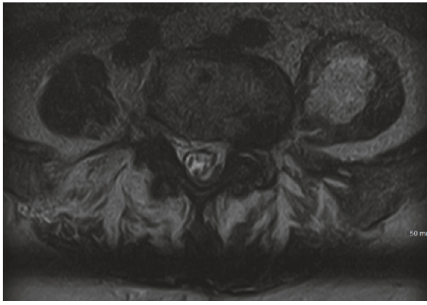
Figure 5: Repeat MRI of the lumbar spine on hospital day 10. Visible here is a persistent fluid collection within the left psoas muscle that has increased in size from previous MRI (Figure 2) despite CT guided